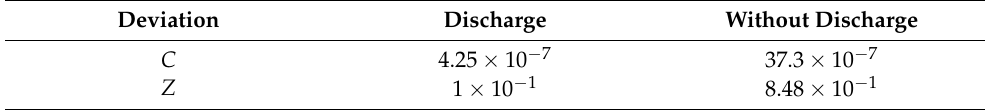
Table 7. Deviations in measurement results with and without